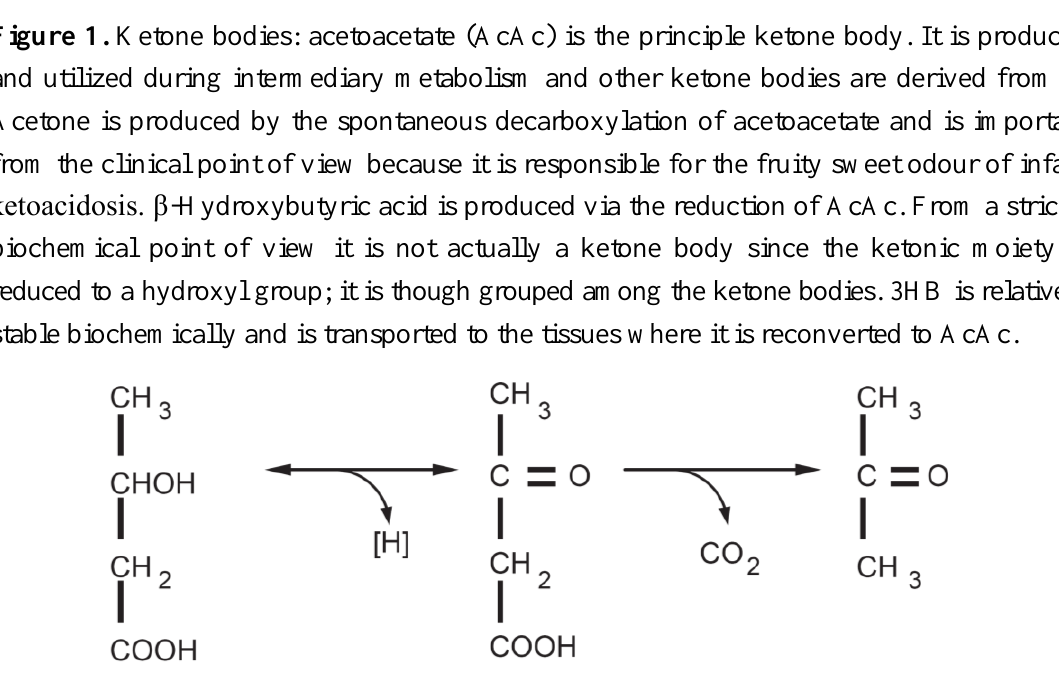
Figure 1. Ketone bodies: acetoacetate (AcAc) is the principle ketone body. It is produced and utilized during intermediary metabolism and other ketone bodies are derived from